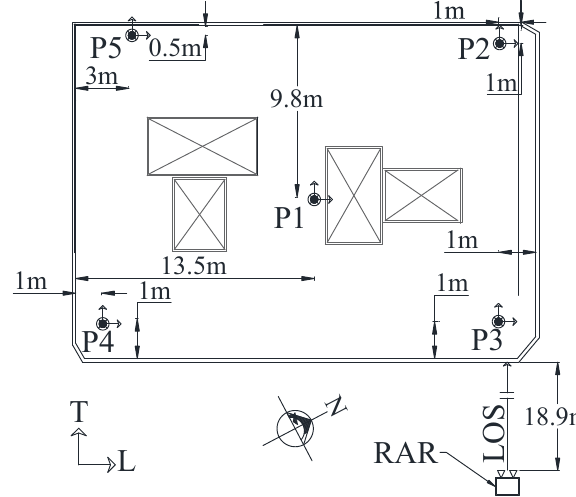
Figure 4. Layout of the roof of the “La Viña” building including the location of the ten-accelerometer network and the relative position of the RAR device.